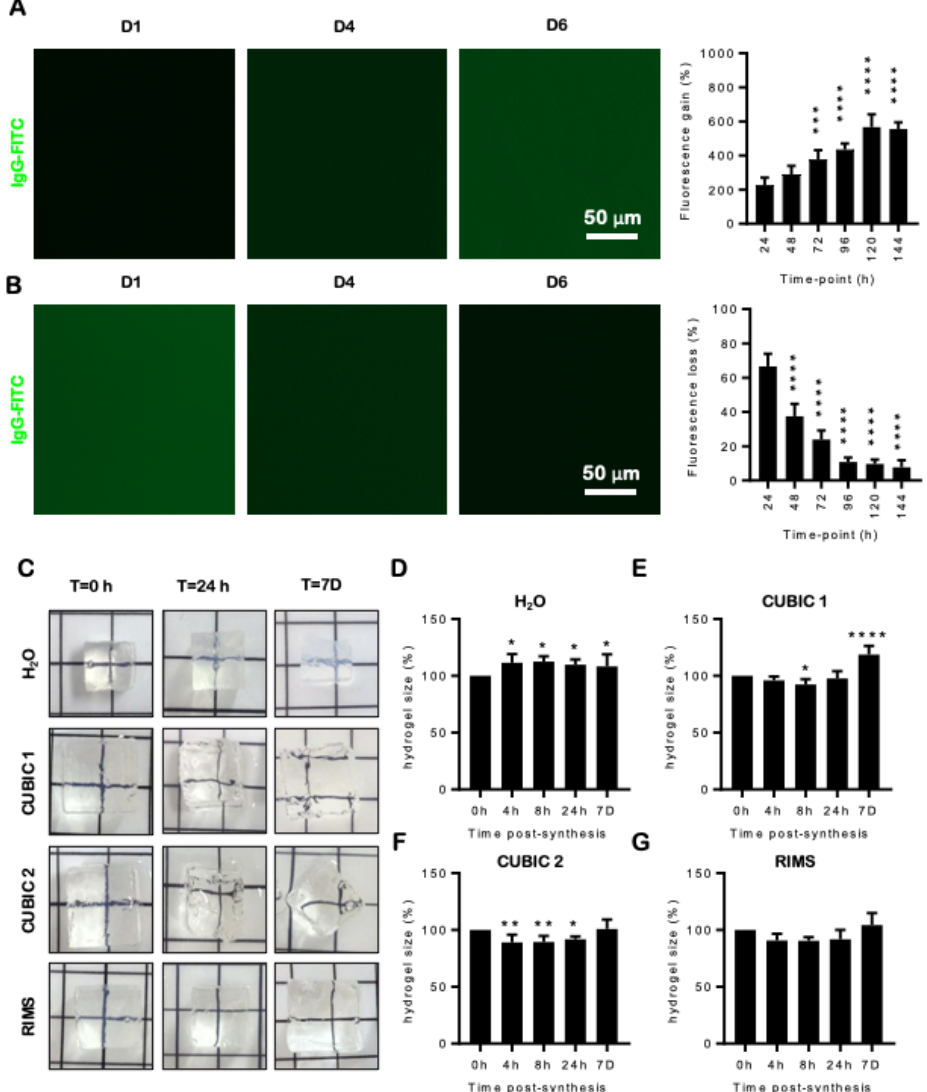
Figure 2. Antibody penetration, size changes in different media and high refractive index hydrogel motility over time. High refractive index hydrogels were assessed for their ability to influx ( A ) and efflux ( B ) IgG-FITC. Fluorescence intensity was quantified over 6 days. Histograms ( A , B ) represent mean (n=6/time point) fluorescence intensity ± SD. Hydrogels were analysed for volume changes in different refractive index matched solutions including distilled water ( C top row and D ), CUBIC-1 ( C second row and E ), CUBIC-2 ( C third row and F ) and RIMS ( C bottom row and G ). Histograms ( D – G ) represent mean (n = 6/time point) hydrogel volume ± SD and are displayed as the % change from t = 0. Data were analysed by one-way ANOVA and Dunn’s multiple comparisons test. * p < 0.05, ** p < 0.01, *** p < 0.001, **** p < 0.0001.